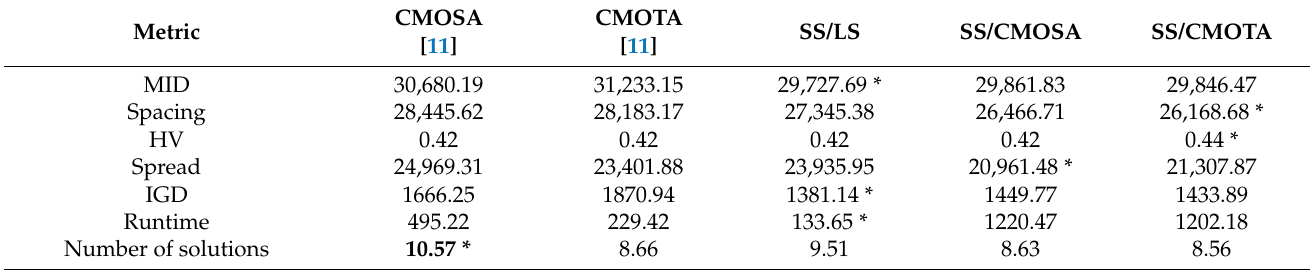
Table 4. Comparison of CMOSA, CMOTA and SS/LS, SS/CMOSA and SS/CMOTA